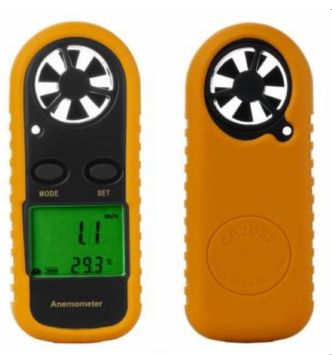
Figure 8. The PST-TL017 anemometer used for the airflow speed check.